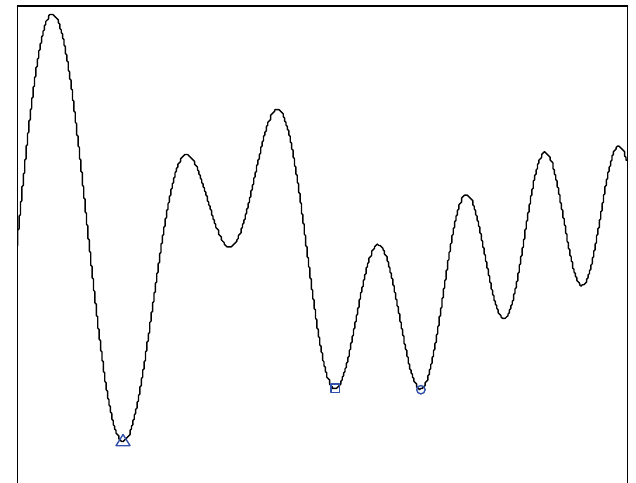
Fig. 2. An example of when both the golden-section search and ternary search find different local minima (the squared point minimum is found by the golden- section search and the circled point minimum is found by the ternary search), whereas the global minimum (the triangled point to the left) is found only by the genetic algorithm.